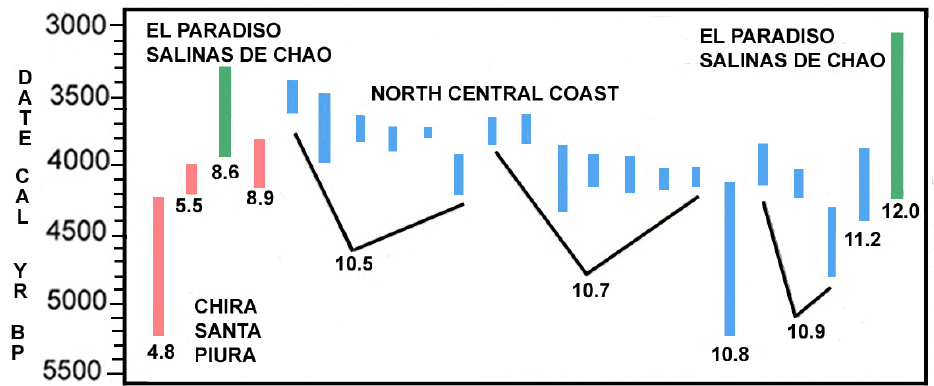
Figure 6. Beach ridge date ranges and locations along the coast of Peru. Band height ranges represent date ± 1 σ values from the mean value; descending (blue) lines indicate beach ridges in a specific area and their dates. Color bands reflect different information sources.